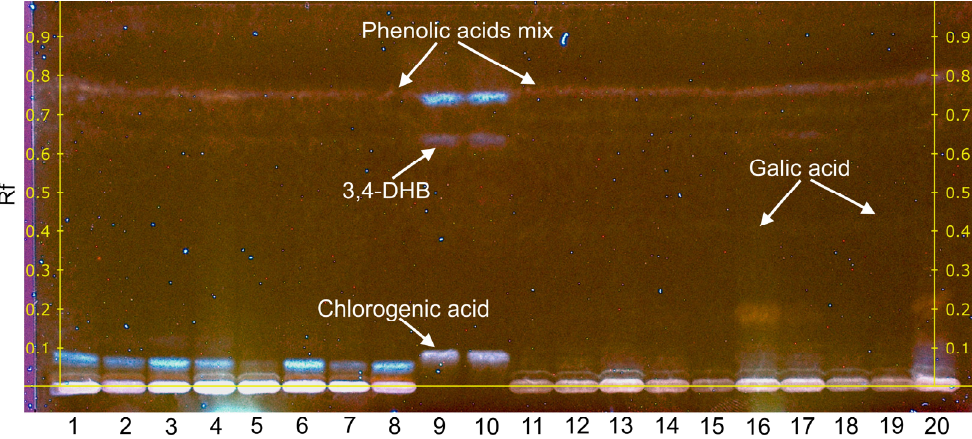
Figure 5. High-performance thin-layer chromatography of Betula and Pinus bound PC extracts after derivatisation of DPPH• solution. Track indications: 1–8, Betula (injection volume 5 μ L); 9–10, phenolic acids mix (injection volume 2 μ L); 11–20, Pinus (injection volume 10 μ L). Mobile phase consisted of chloroform/ethyl acetate/acetone/formic acid (40:30:20:10 v / v / v / v ).